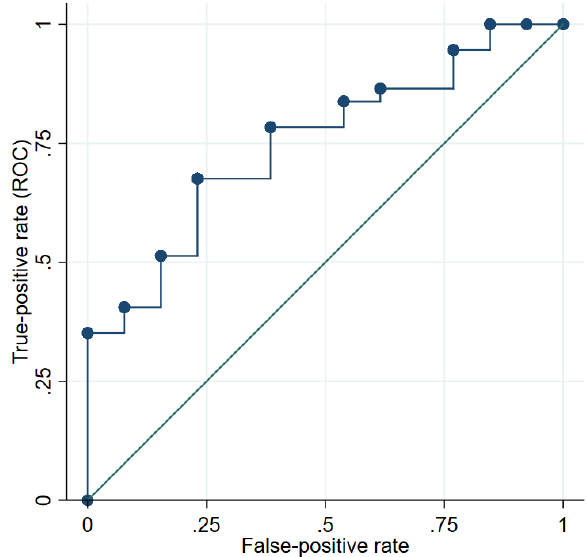
Figure 1. Receiver Operating Characteristic (ROC) curve for the malnutrition PG-SGA score based on the EMR review compared to PG-SGA bed-side screen.